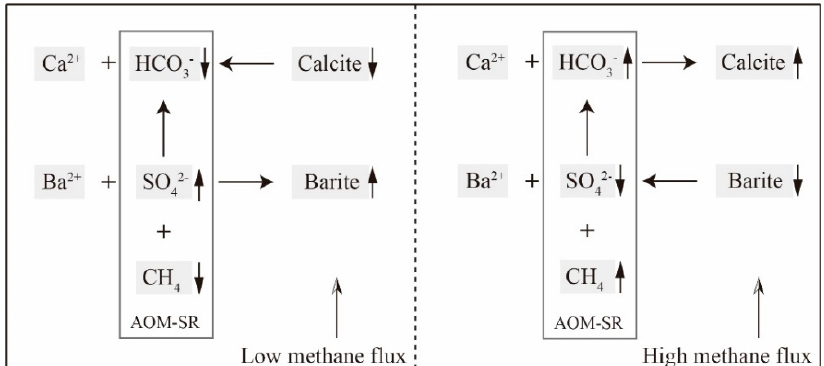
Figure 7. Schematic diagram of reactions at low/high methane flux condition (the arrow indicates relative richness or depletion).